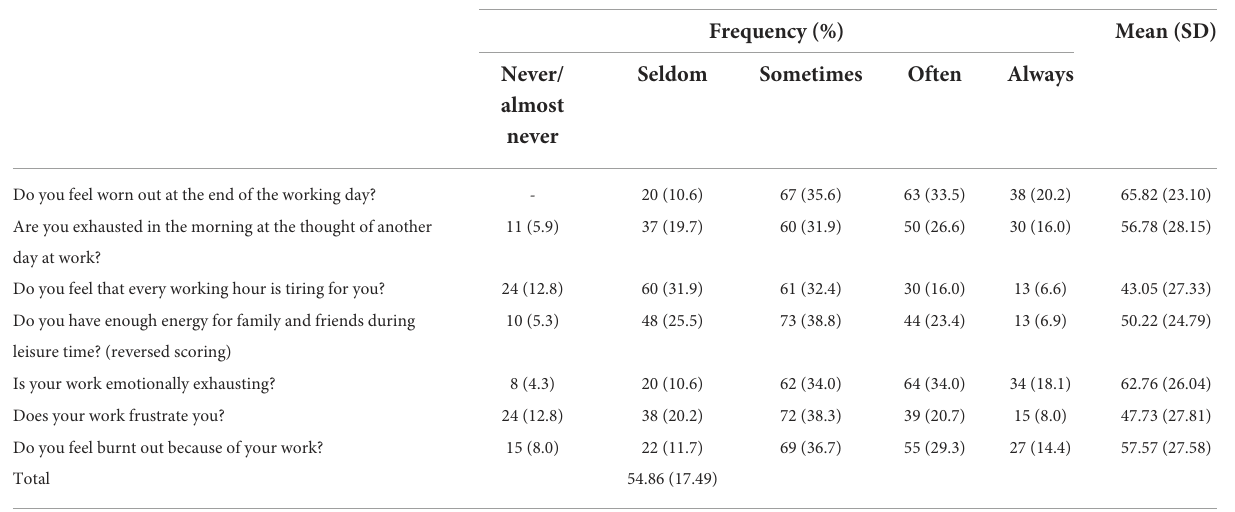
TABLE 2B Frequency distribution, mean and SD of the work-related burnout scale.